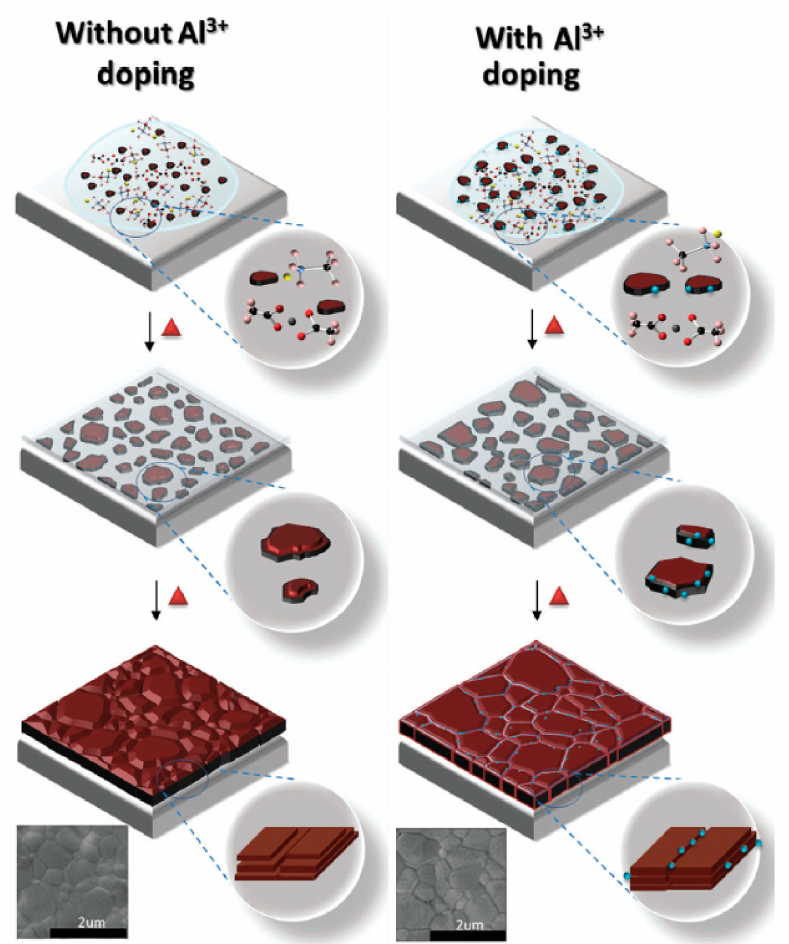
Figure 2. The proposed perovskite thin film growth under the influence of Al 3 + . C, N, H, O, I, Pb and Al are depicted in black, blue, pink, red, yellow, grey and cyan respectively. Figure adapted with permission from Energy Environ. Sci. 2016 , 9 , 2892–2901, Reference